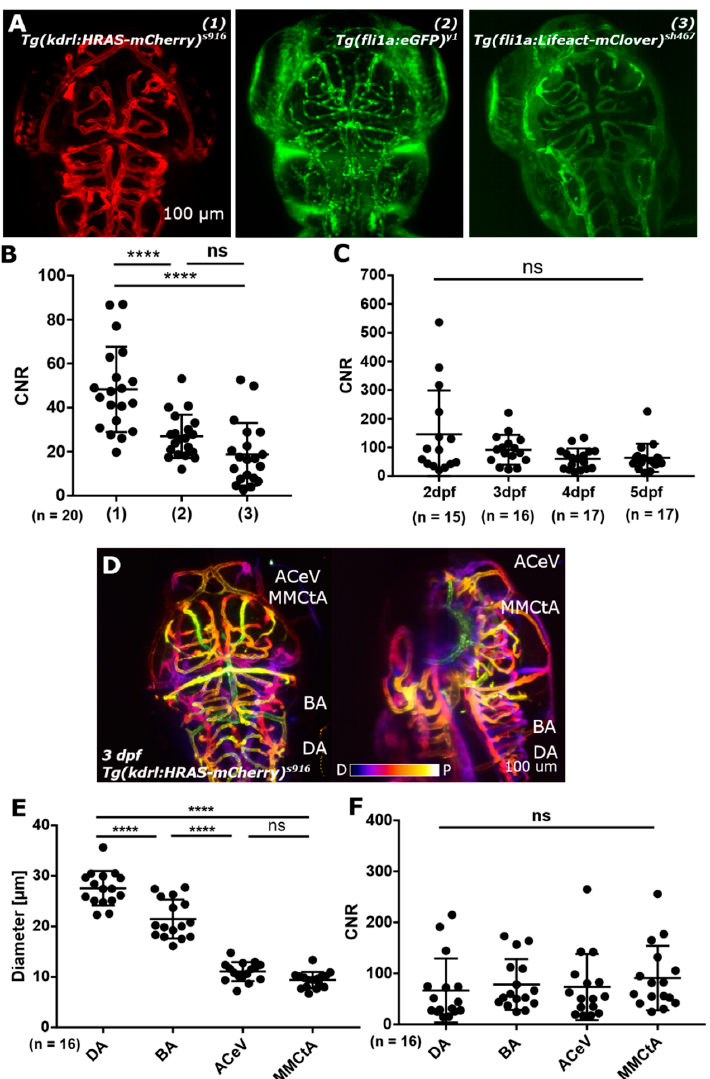
Figure 2. ( A ) Image quality was assessed by contrast-to-noise ratio (CNR) level measurement in three different transgenic lines, which harbour different reporter constructs (promotor as well as reporter; 1,2,3). ( B ) CNR levels in these transgenic reporter lines showed a statistically significant difference between (1) and (2) as well as between (1) and (3), with p < 0.0001 (****) for both. Between (2) and (3) no statistically significant difference was found ( p 0.0898; ns). ( C ) CNR levels from 2-to-5 dpf showed no statistically significant difference ( p 0.1032; ns). ( D ) Light sheet fluorescence microscopy (LSFM) allows to visualize vessels from the most dorsal plane (p - proximal image plane; e.g., anterior cerebral vein (ACeV)) to vessels which are a few hundred micrometer inside the embryo (d distal image plane; e.g., dorsal aorta (DA)). ( E ) Vessels in the dorsal cranial zebrafish vasculature with different diameters show no statistically significant difference in CNR levels (( F ); p 0.3007 (ns); Figures ( A ) and ( D ) reproduced with permission from [13] under licence